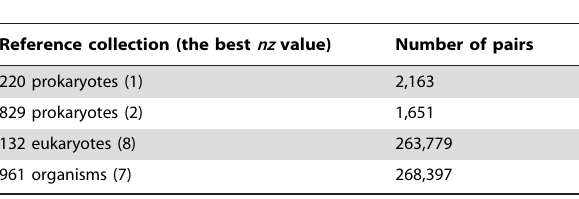
Table 4. Number of pairs that passed the non-zero filter and the first stage using different reference